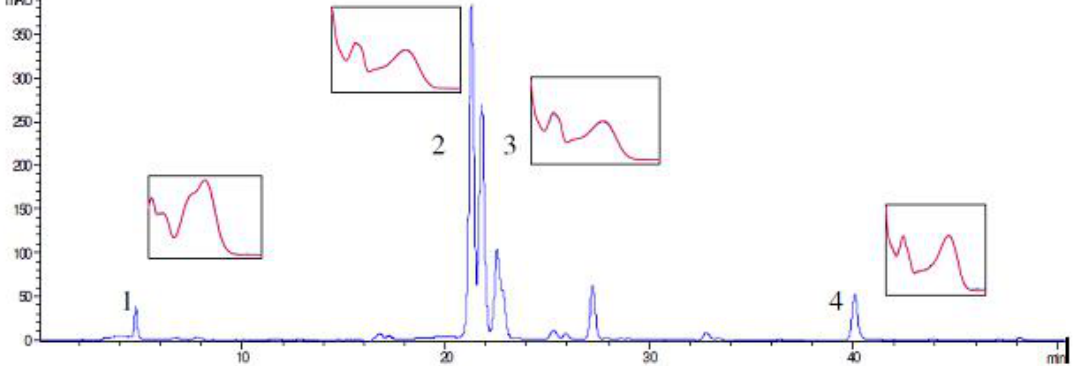
Figure 1. HPLC profile of St. John’s Wort methanolic extract: (1) chlorogenic acid, (2) rutin, (3) hyproside, (4)